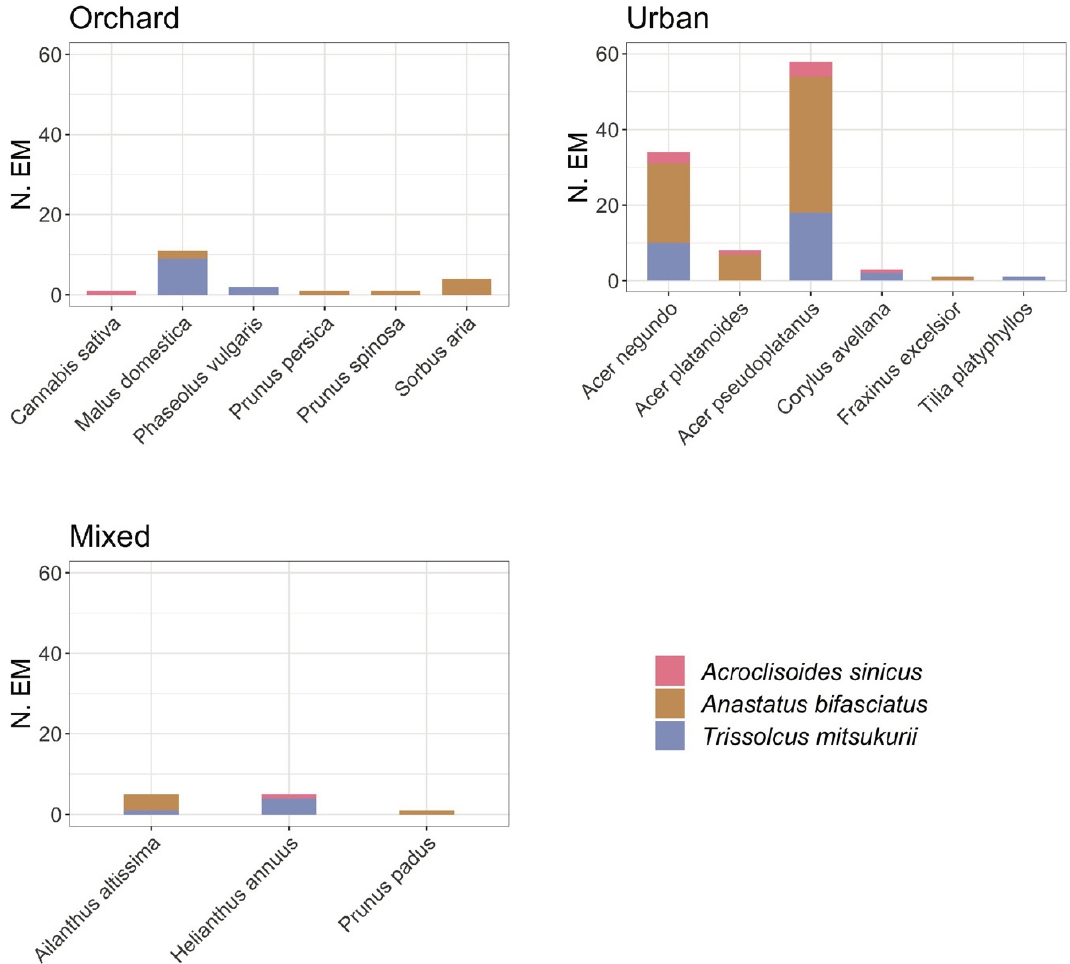
Figure 1. Plant host species and context (orchard, mixed, urban) for the collected Halyomorpha halys egg masses parasitized by Anastatus bifasciatus , Trissolcus mitsukurii , and Acroclisoides sinicus ; N.E.M (number of egg masses).